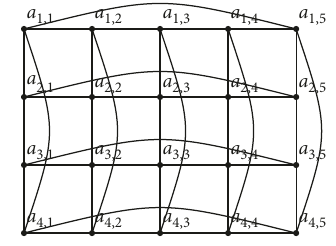
Figure 3: Torus grid graph C